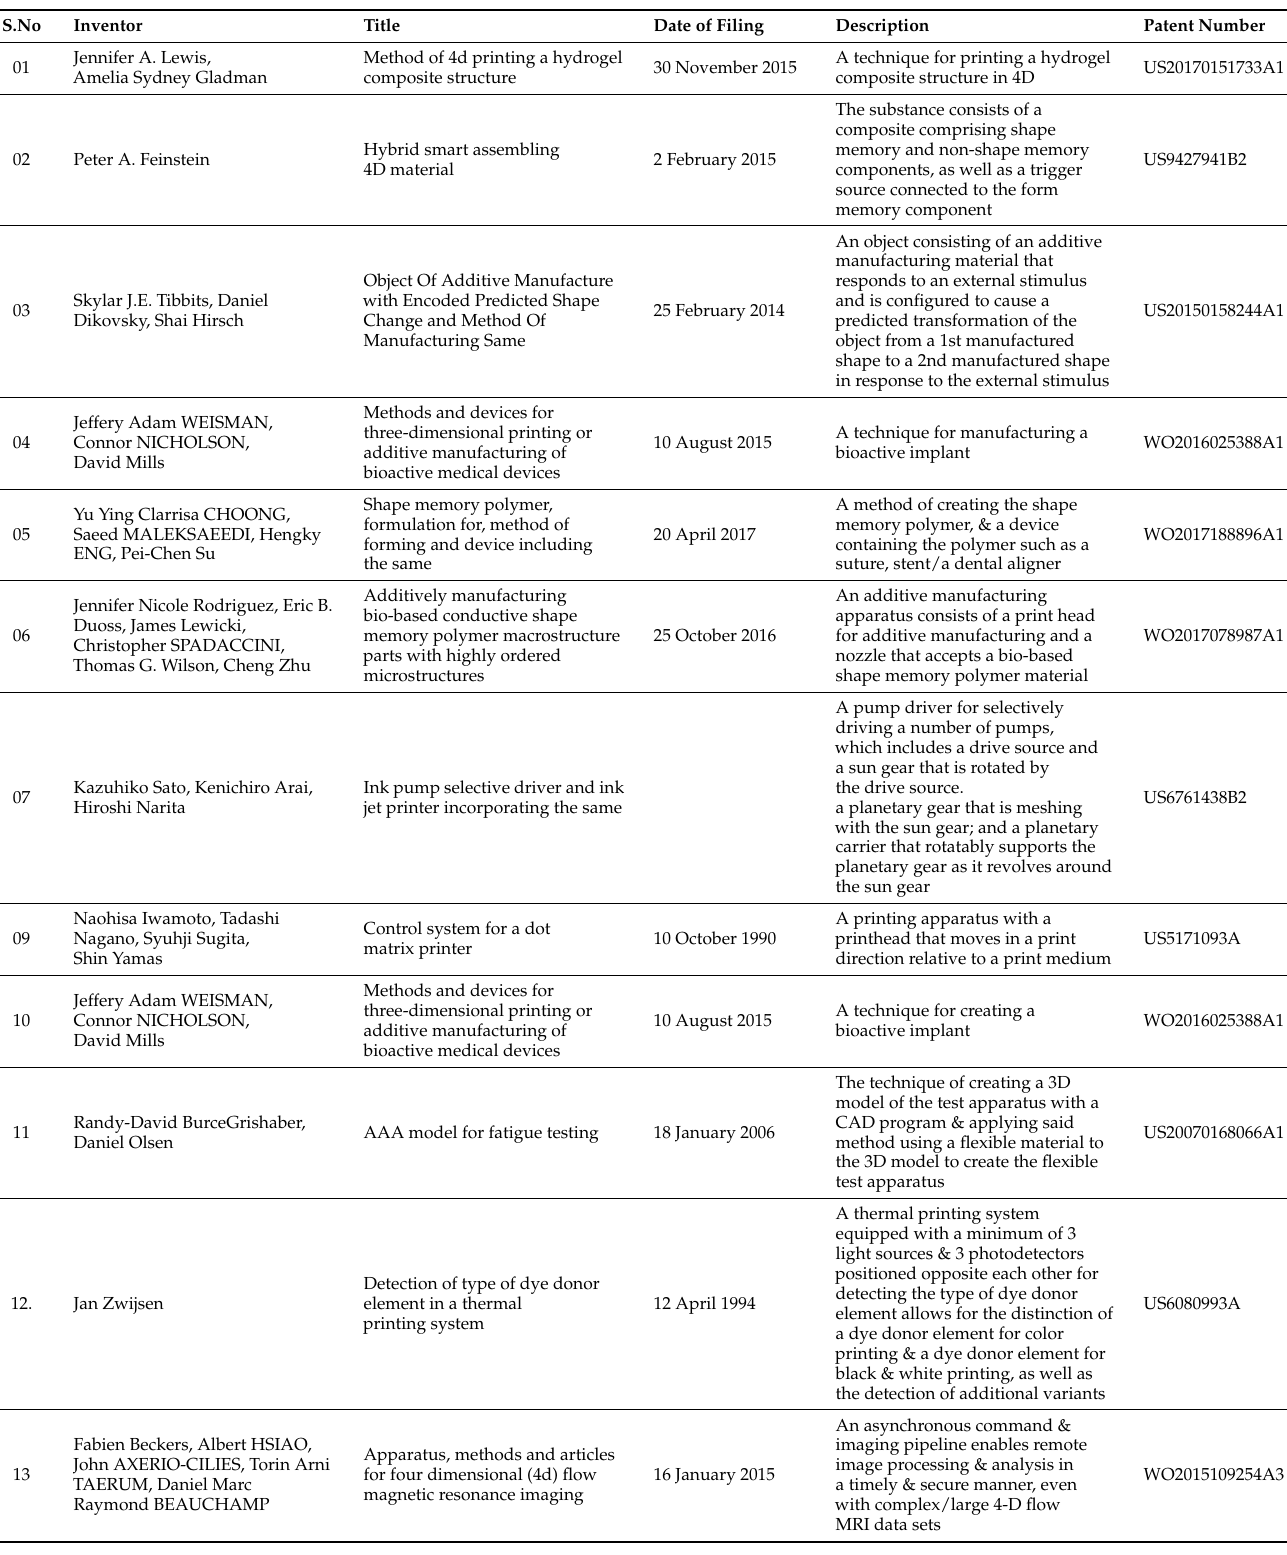
Table 4. List of Patents for 4D Printing